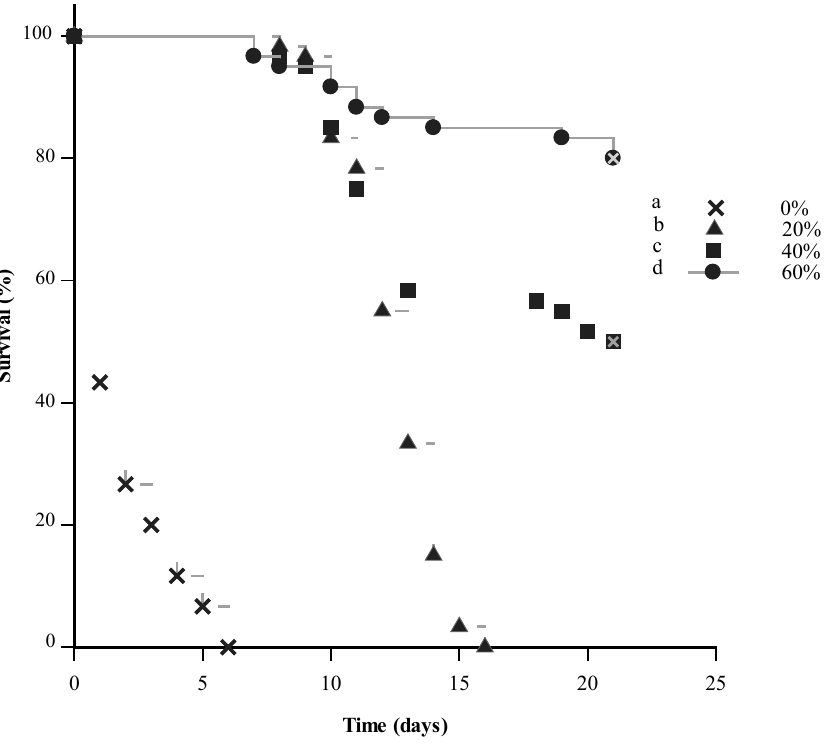
Fig 4 . Percentage of survival of Coptotermes testaceus workers after being exposed to four substrate moistures (0%, 20%, 40% and 60%) at 20 °C and 100% RH, n = 6. Different letters on substrate moisture indicate significant differences (Holm Sidak, α =